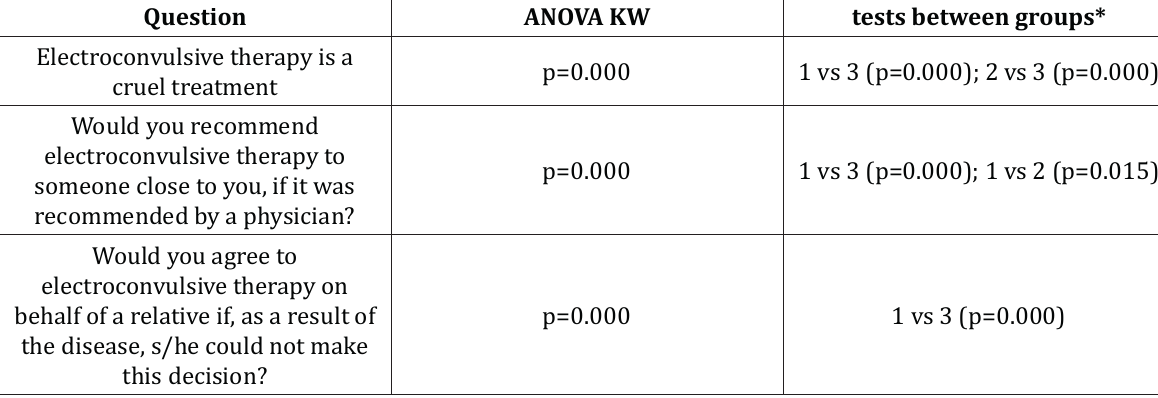
Table 3. Statistical confirmation of differences concerning the attitudes towards electroconvulsive therapy depending on the field of study